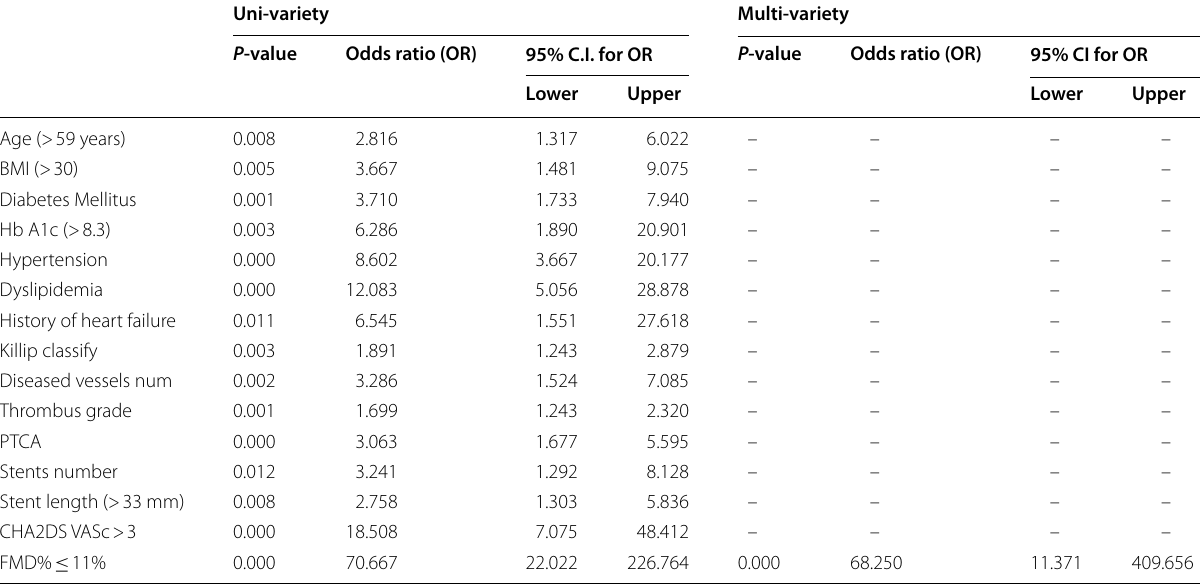
Table 5 Multiple regression of the independent predictors for no-reflow